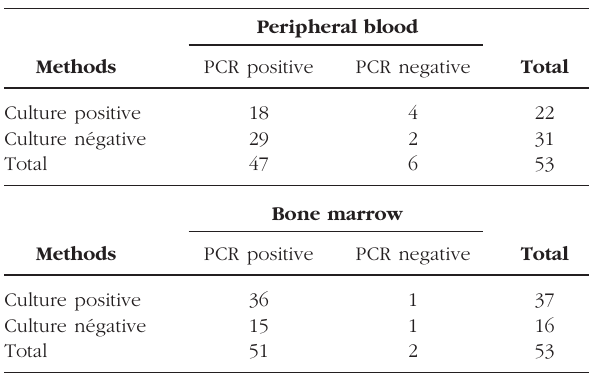
Table III. – Comparison of PCR assays (R221/R332 and/or Lei70L/ Lei70R) and in vitro cultivation performed on peripheral blood and bone marrow for VL